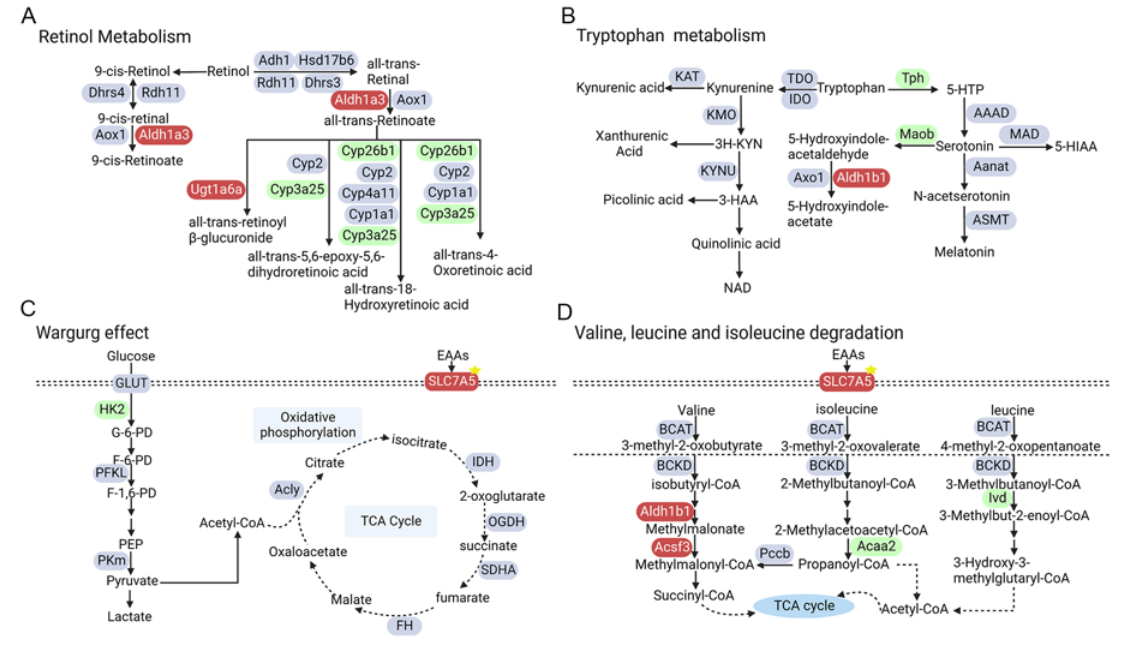
Figure 5. Overview of representative metabolic pathways with enzyme alterations at transcriptional levels in mice retina undergoing diabetic retinopathy. Down-regulated and up-regulated differential genes are in blue and red, respectively. ( A ) Retinol metabolism pathway; ( B ) Tryptophan metabolism pathway; ( C ) Warburg effect pathway; ( D ) Valine, leucine and isoleucine degradation pathway.